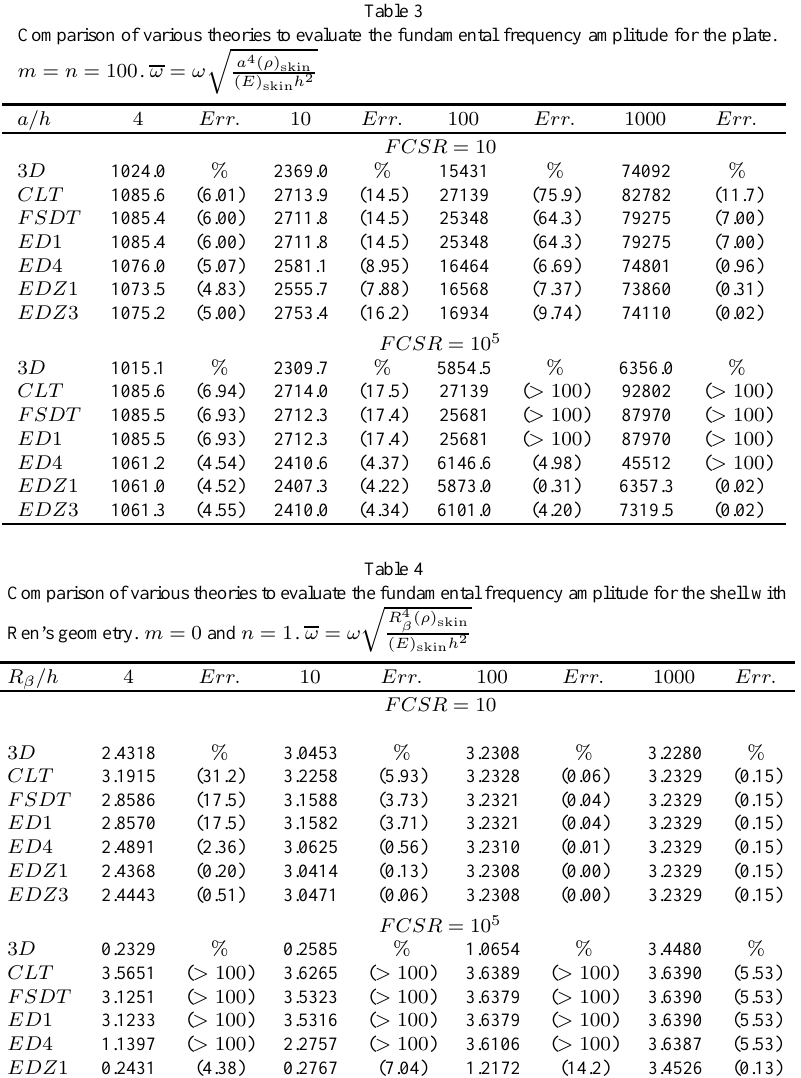
Table 3 Comparison of various theories to evaluate the fundamental frequency amplitude for the plate.